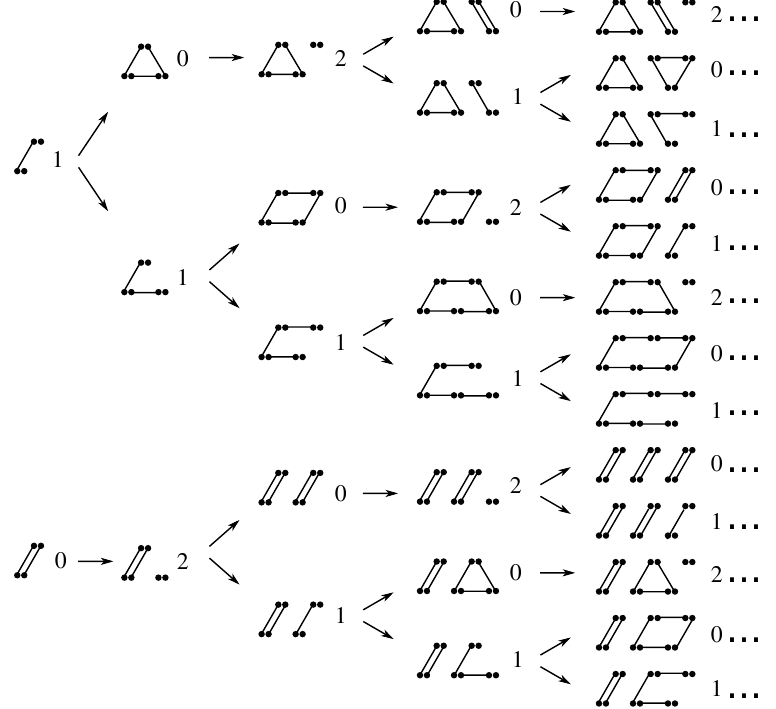
Figure 18: (a) Construction of all possible states of the left block for the QLM (see main text for details)